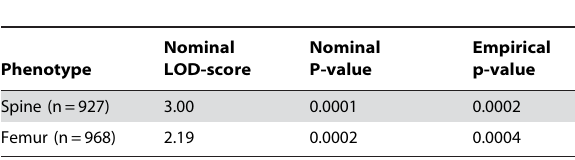
Table 4. Highly Suggestive/Suggestive Multipoint LOD- scores on Chromosome